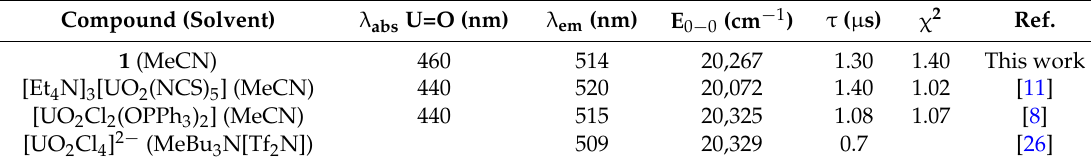
Table 1. Comparison of photophysical properties of selected uranyl halides and pseudohalides. Compound